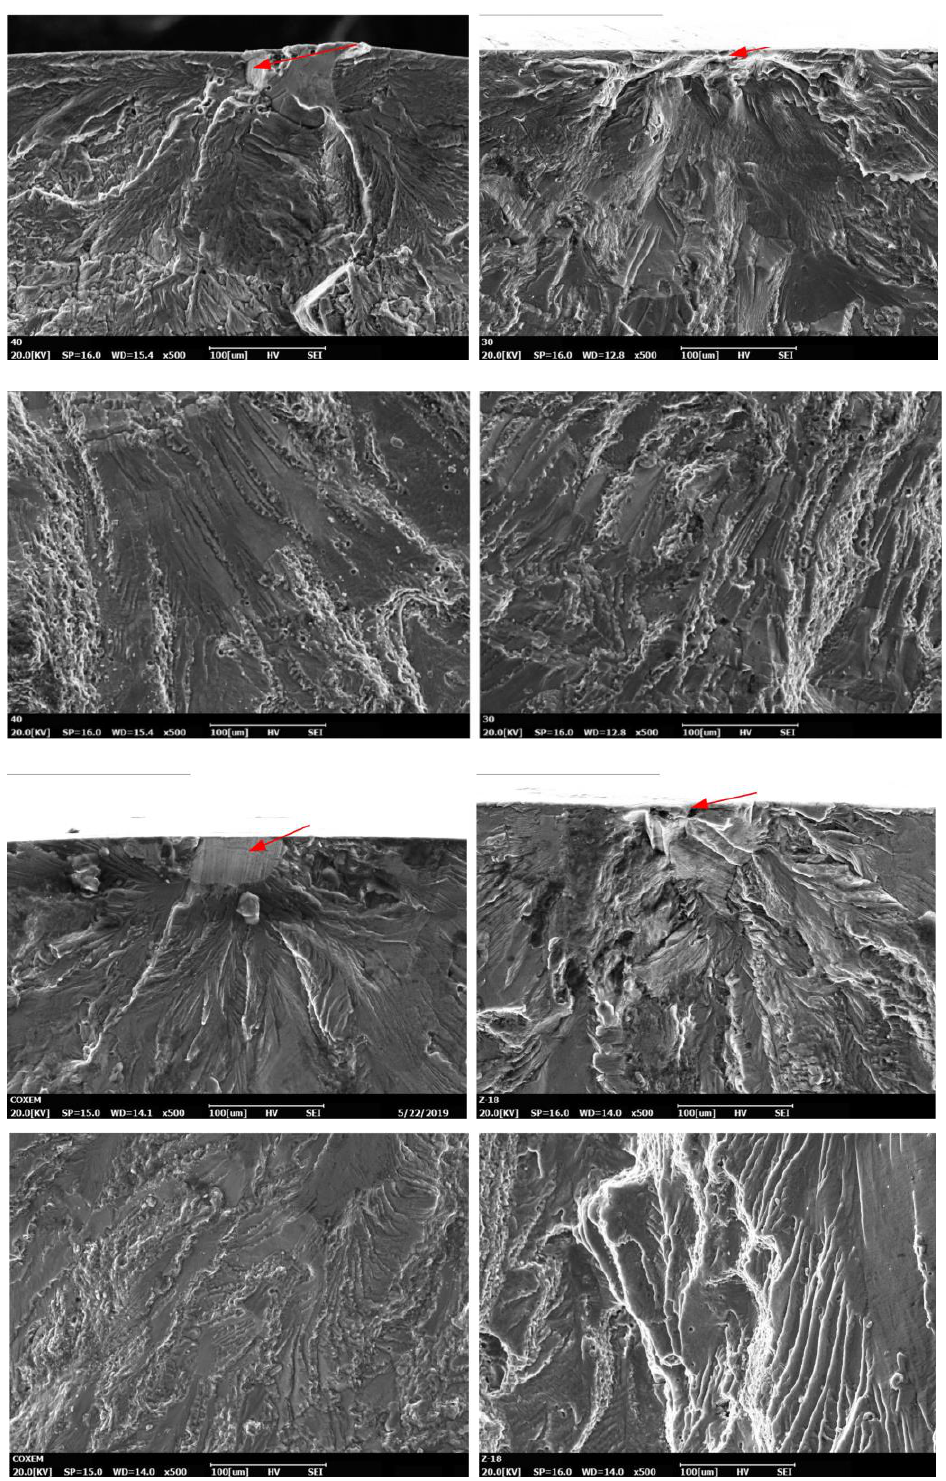
Figure 10. Frequency reduction for vibration fatigue experimental end criteria.